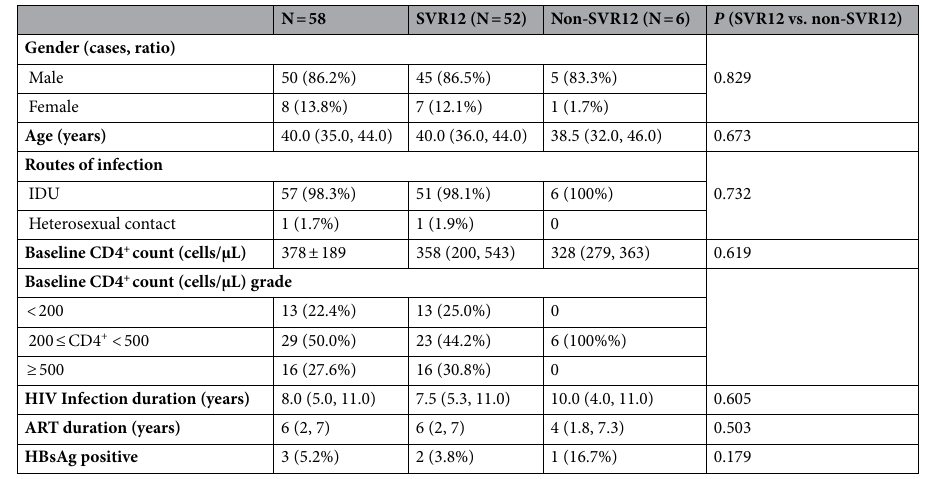
Table 1. Baseline characteristics other than HCV infection of study subjects (grouped by